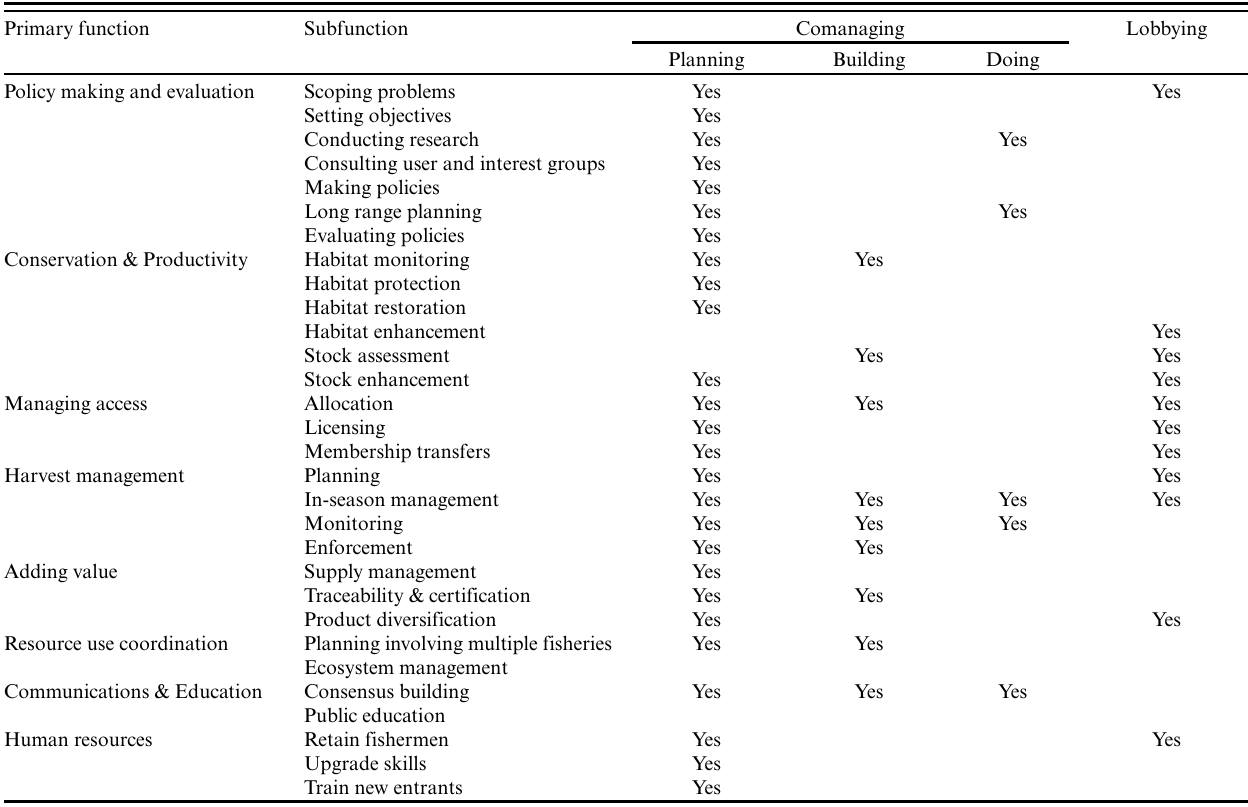
Table 3 . Fisheries management functions and Sustainable Marine Fisheries and Communities Alliance (SMFCA) goals and activities, 2008-2012 (Government of British Columbia 2010, Fernandes 2011, Thorkelson 2012, City of Prince Rupert 2013; SMFCA 2010, personal communication, unpublished documents ). “Yes” in table below indicates that SMFCA is engaged in a particular